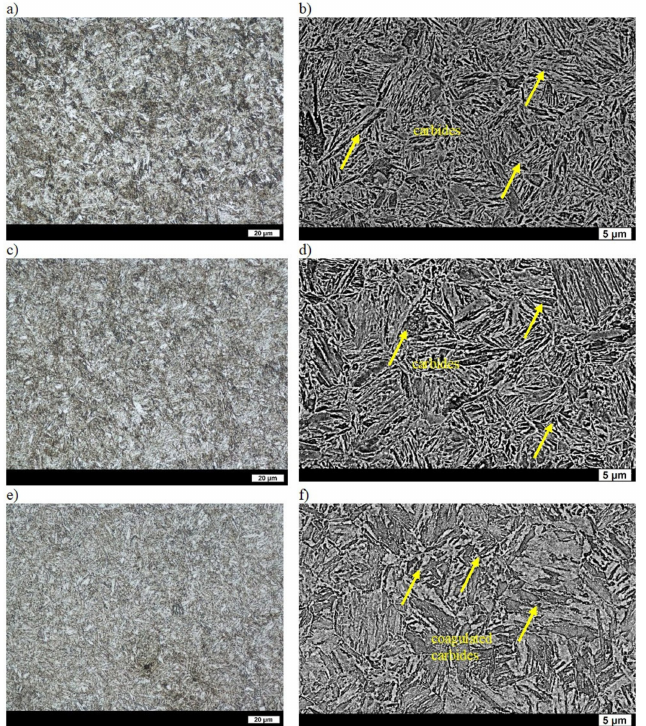
Figure 5. Microstructure of ingot No. 3 after quenching and tempering: ( a ) at 200 ◦ C, LM; ( b ) at 200 ◦ C, SEM; ( c ) at 400 ◦ C, LM; ( d ) at 400 ◦ C, SEM; ( e ) at 600 ◦ C, LM; ( f ) at 600 ◦ C, SEM. Etched with 3% HNO 3